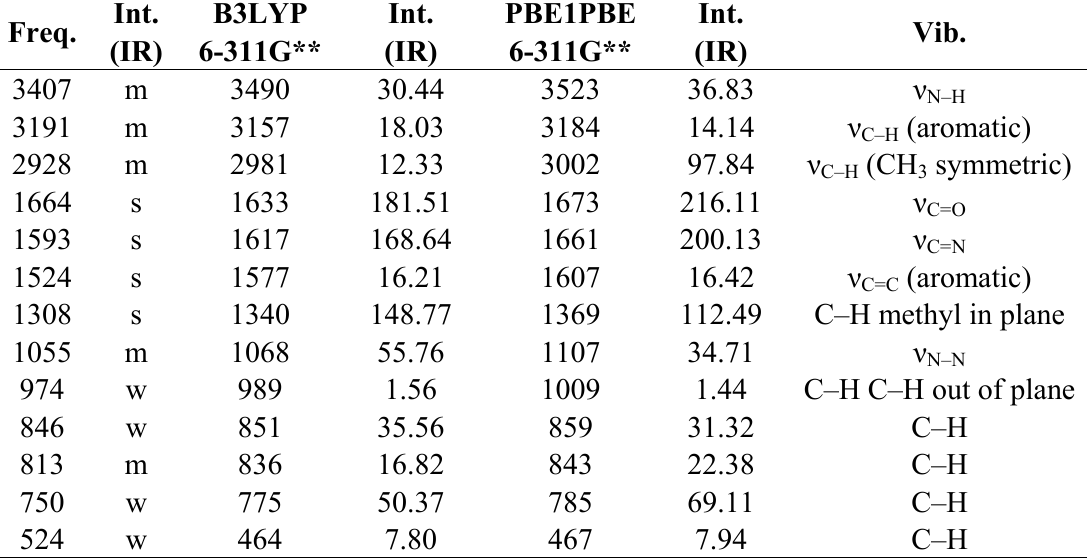
Table 5. Theoretical and experimental IR spectral data (cm − 1 ) of compound